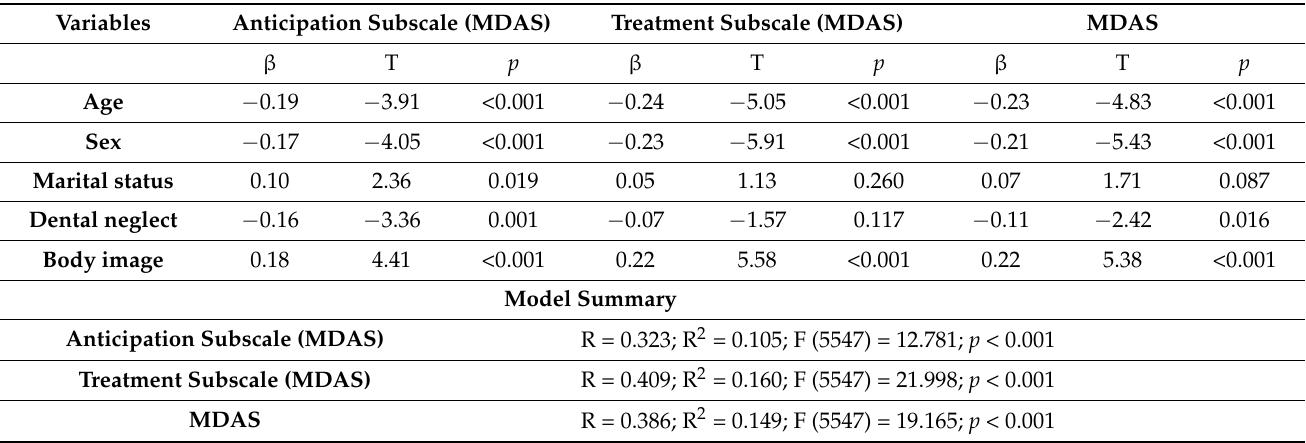
Table 2. Regression results for the association of body image with the MDAS and its